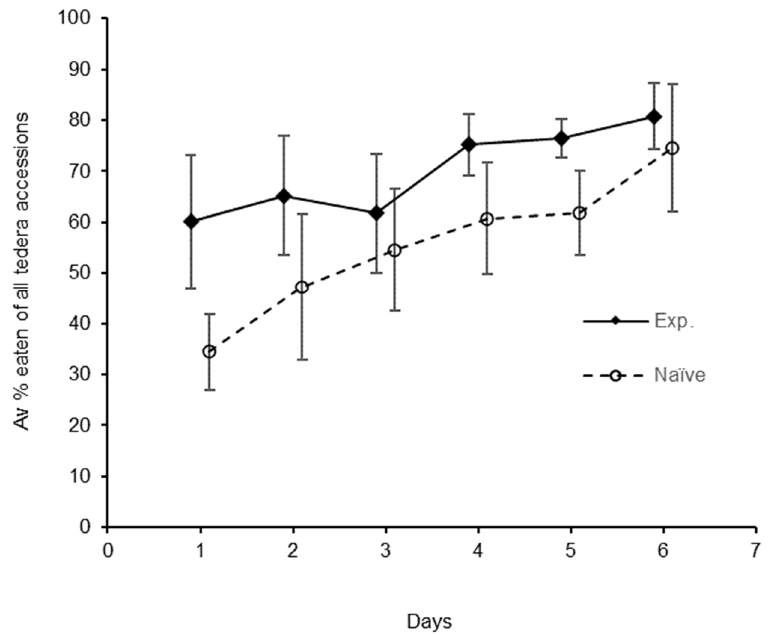
Figure 4. The average percentage of the tedera offered that was eaten in the first hour by both the experienced (diamond) and the naïve (circle) sheep over the six days of experiment 1.